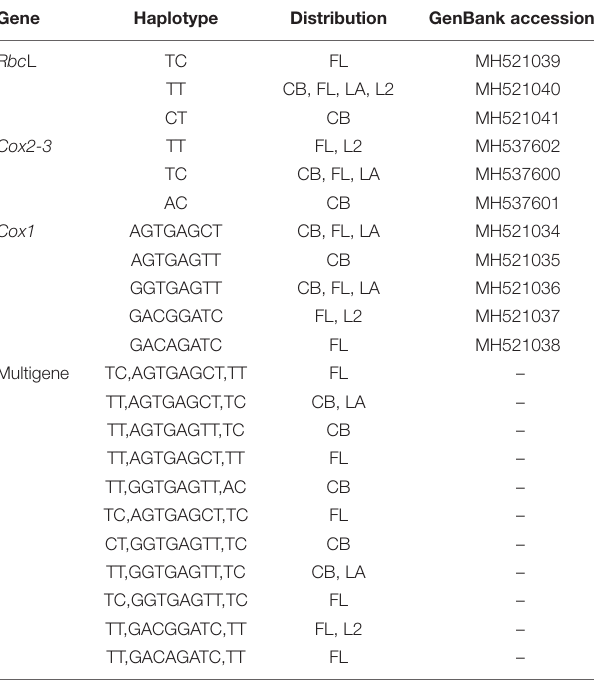
TABLE 4 | Population differentiation of Botryocladia occidentalis in three distant regions of the Gulf of Mexico and before vs. after the Deepwater Horizon Oil Spill (DWH).